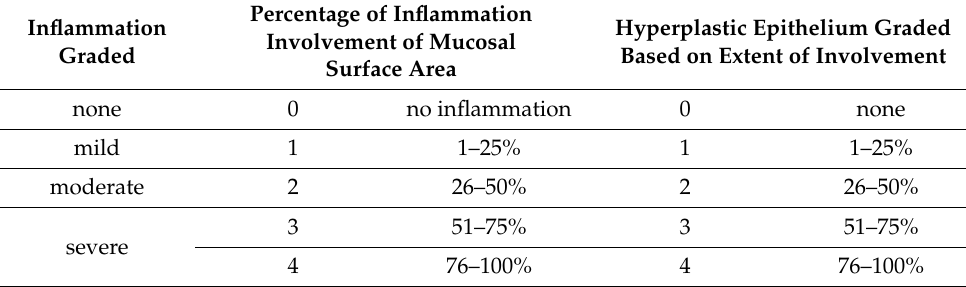
Table 2. Colon tissue histological examination for